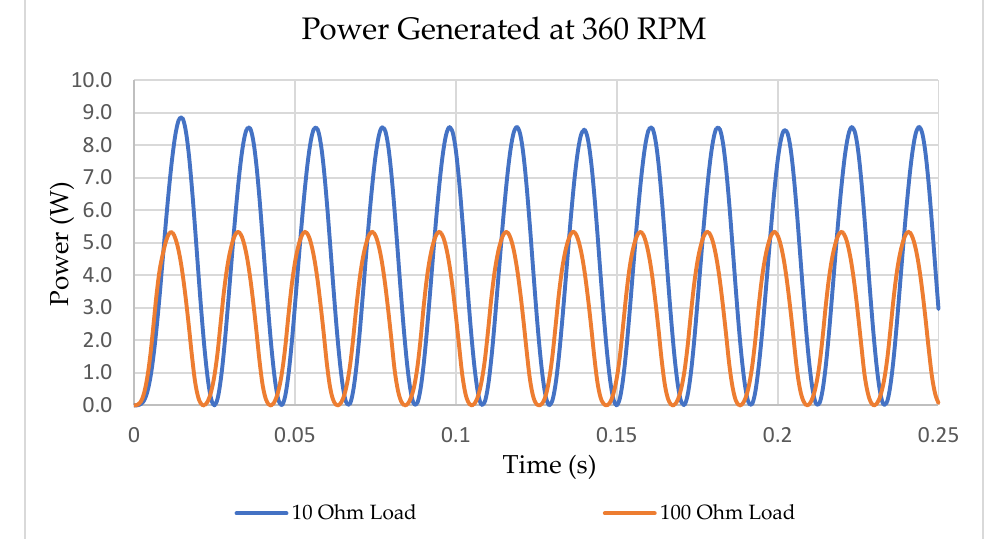
Figure 14. Power generated at 360 RPM. At 360 RPM generator was able to generate a peak power of 8.6 W under a 10-ohm load condition and 5.3 W under a 100-ohm load condition. Figure 15 shows the output power generated at 450 RPM.